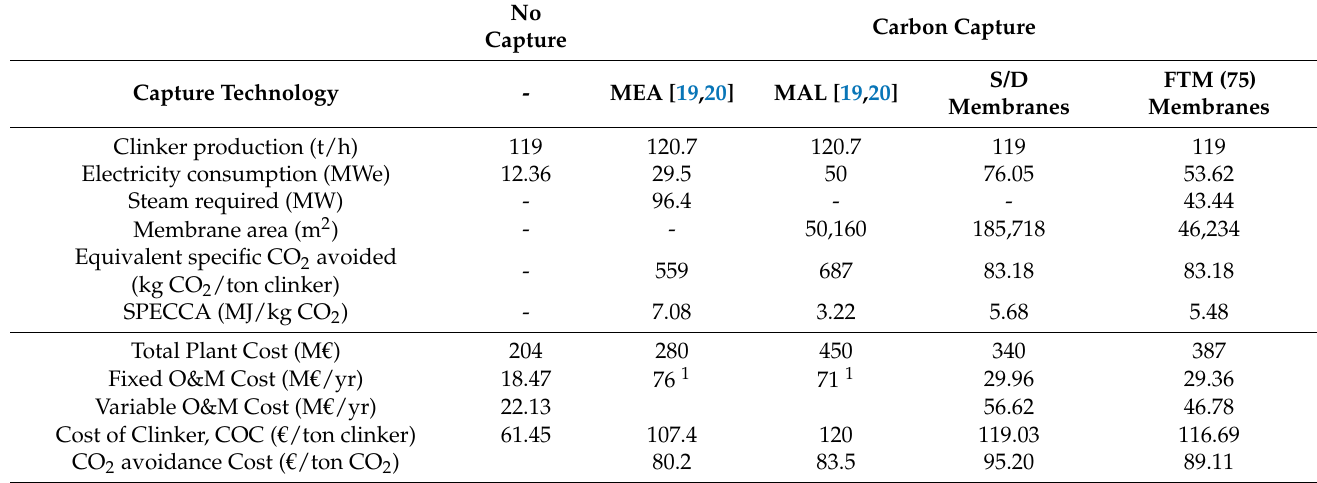
Table 5. Comparison of different carbon capture alternatives.